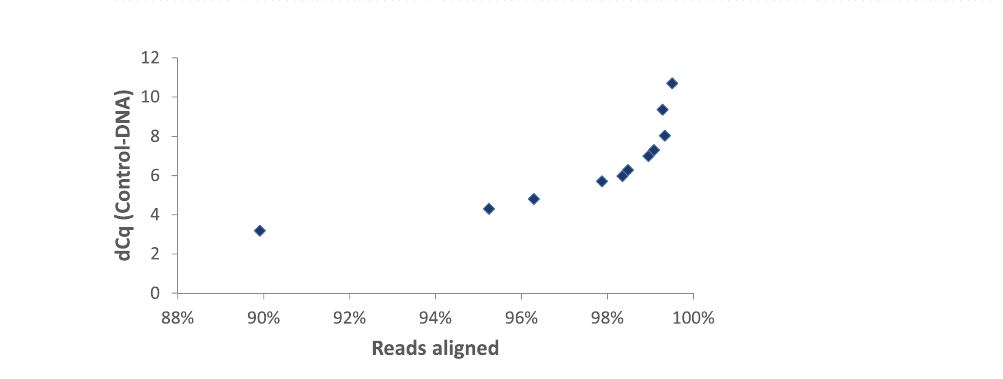
Figure 4. Fraction of aligned reads plotted over dCq value of Control-DNA after WGA. About 2.3 × 10 6 reads are aligned per library to the human genome. The fraction of reads that are aligned to the human genome changes with the degree of damaging of cells. The dCq value of ControlDNA spiked during WGA of single human cells correlates exponentially with the fraction of the reads aligned to the human